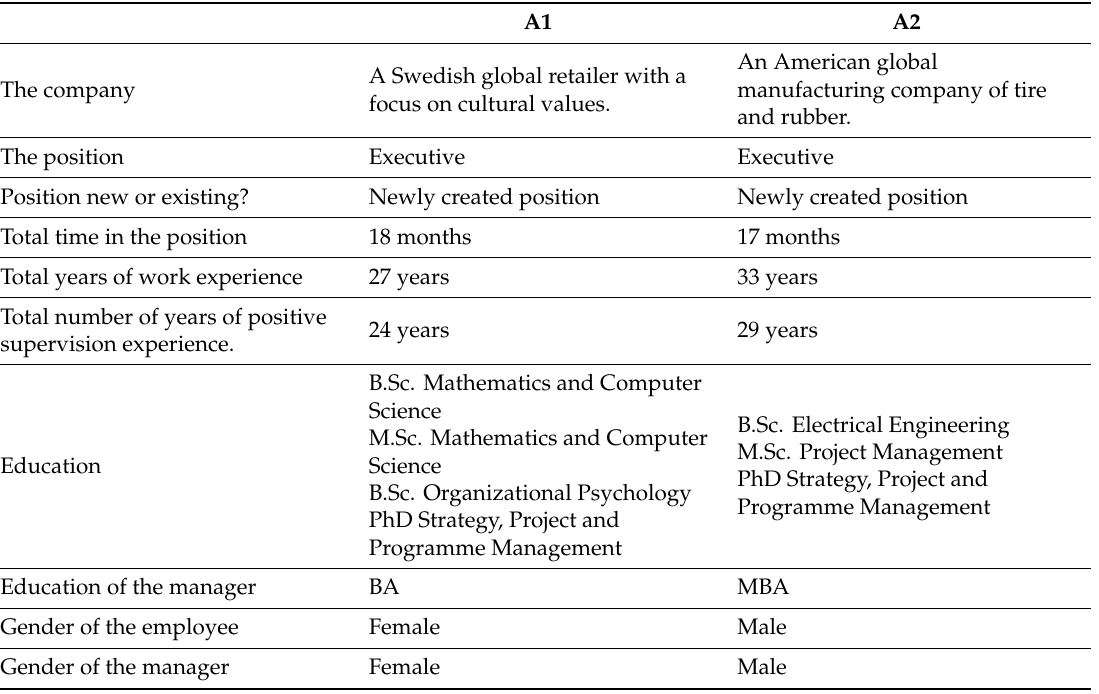
Table 1. The Studied